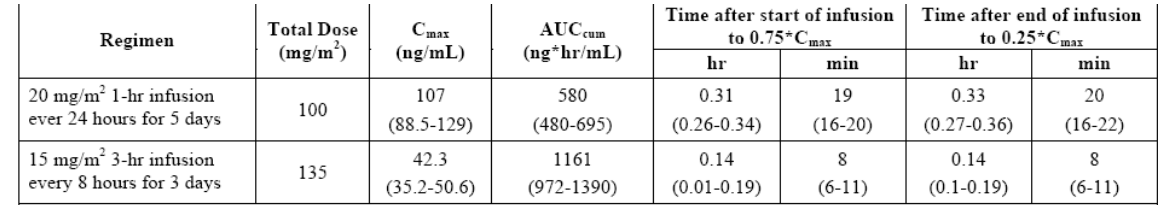
Table 15 - Comparison of dosing regimens PK parameters